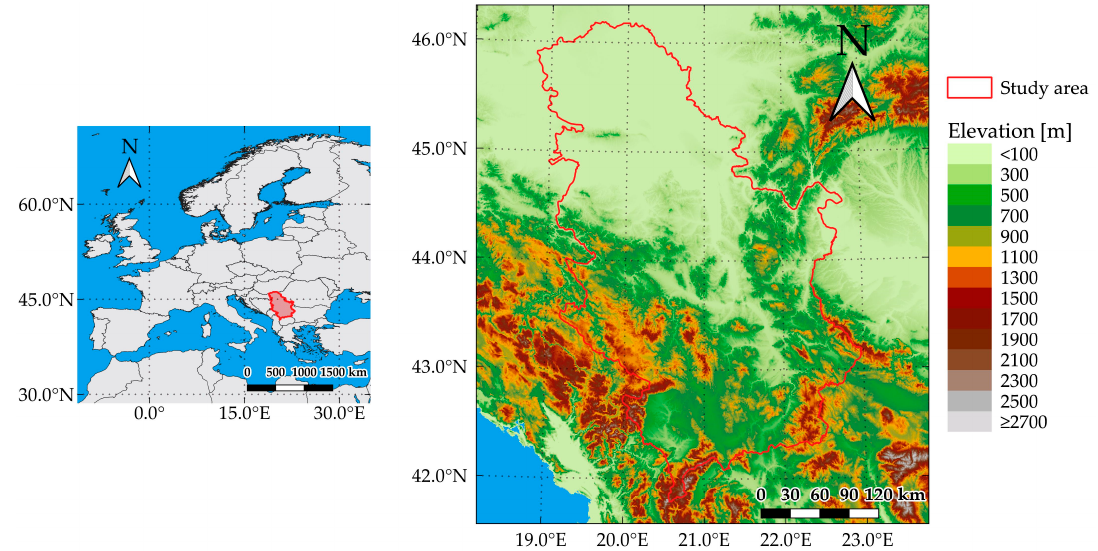
Figure 1. The location of study area—Republic of Serbia.